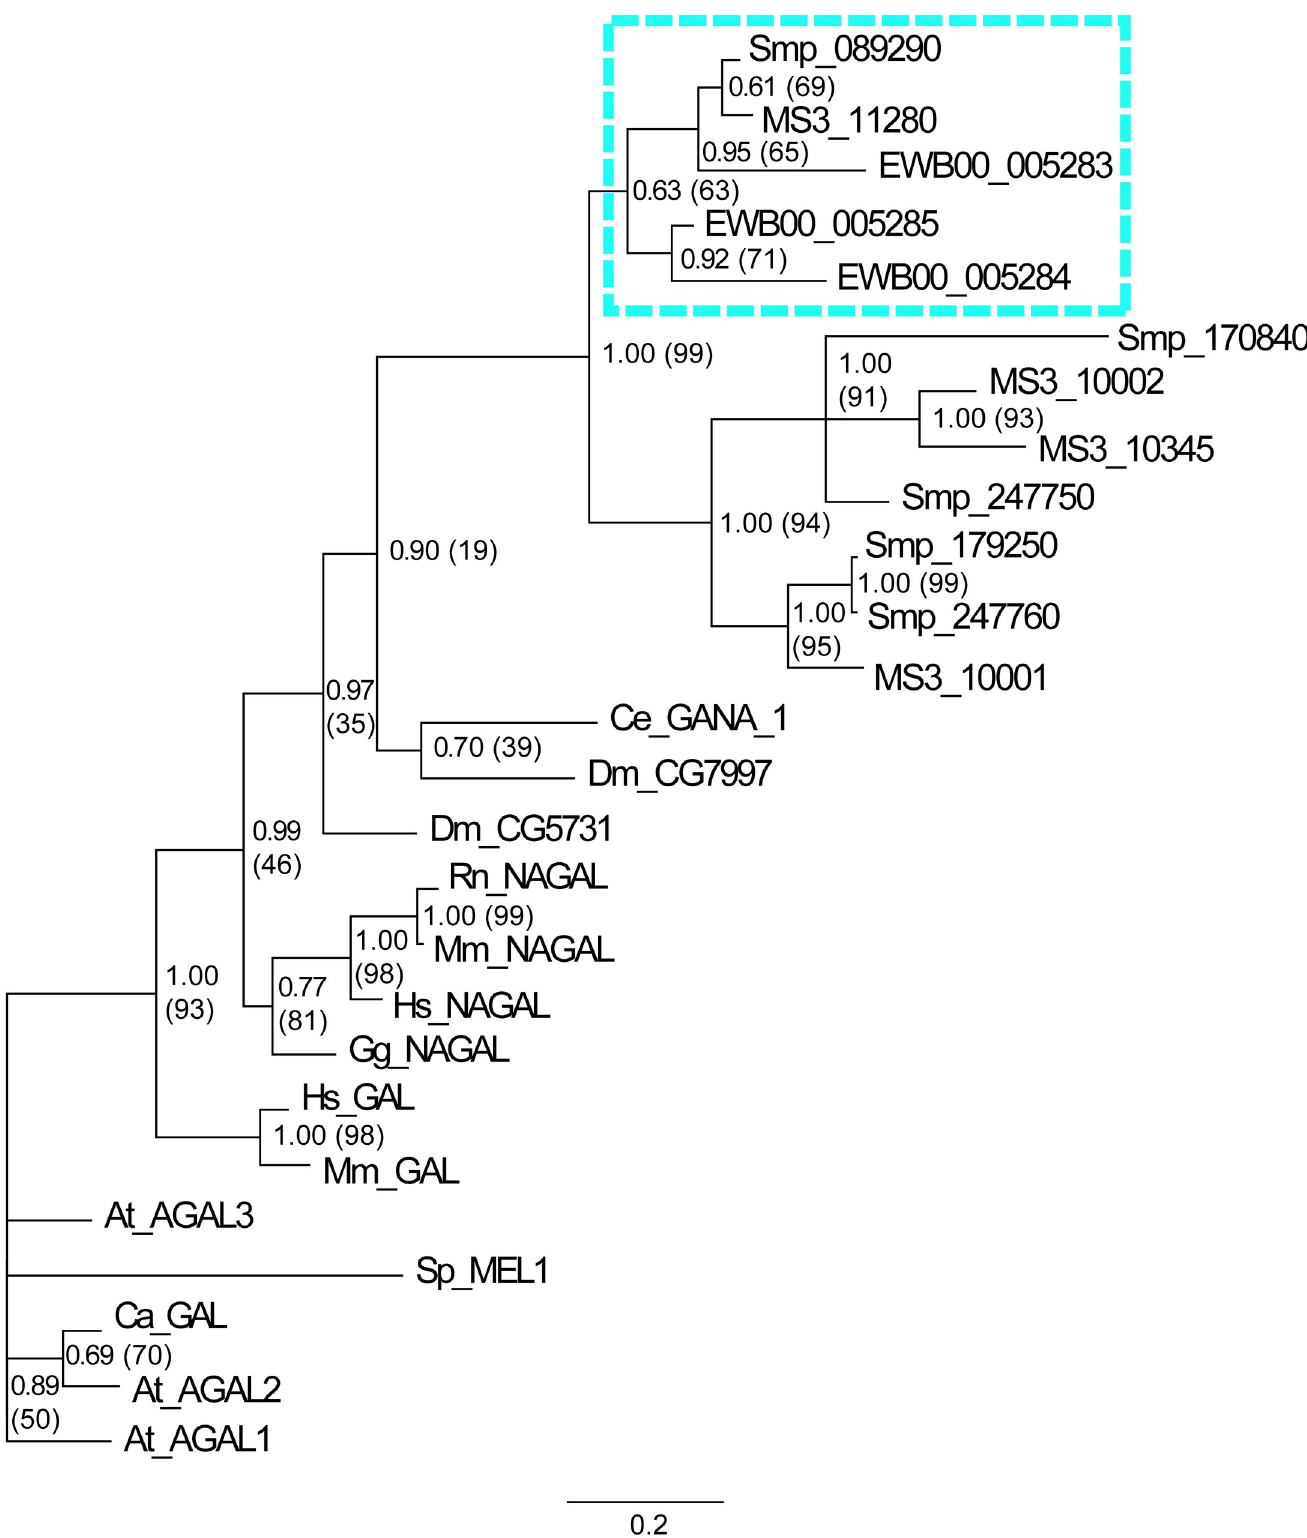
Fig 2. Schistosoma melibiase-2 domain containing proteins with conserved catalytic aspartic acid residues cluster in a distinct clade of GH27 family members. Phylogenetic analyses were conducted using a concatenated multiple sequence alignment of Schistosoma proteins that contained > 70% of the residues within